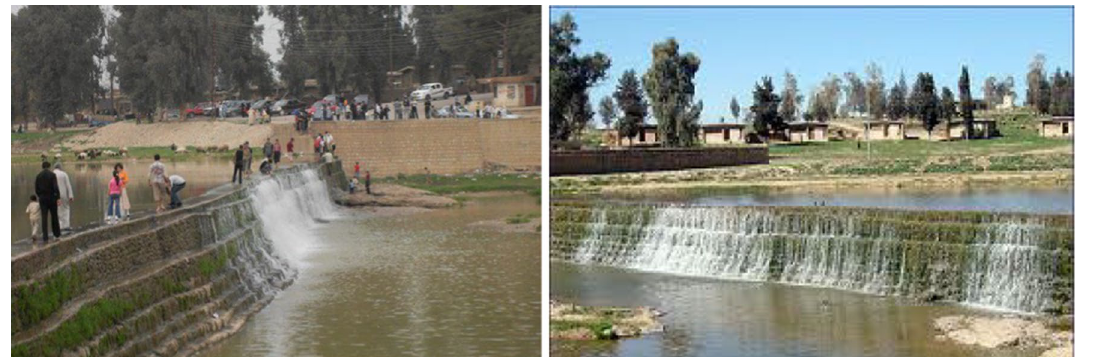
Fig. 2 Front and side view of the stepped